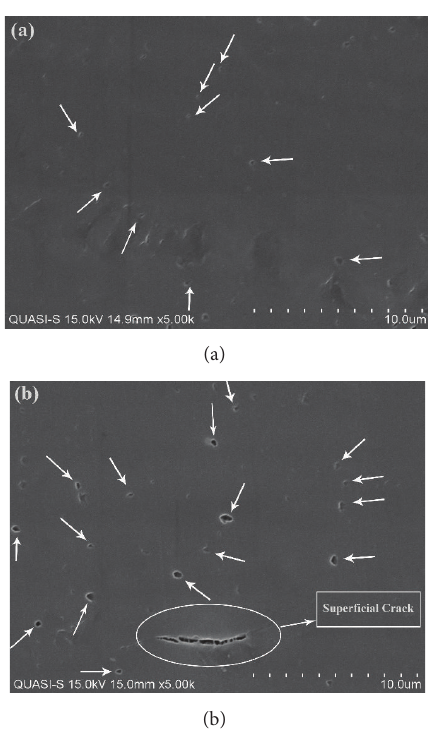
Figure 14: SEM observation on the polished matrix surface before (a) and after (b) 800 h thermooxidative aging at 82 ∘